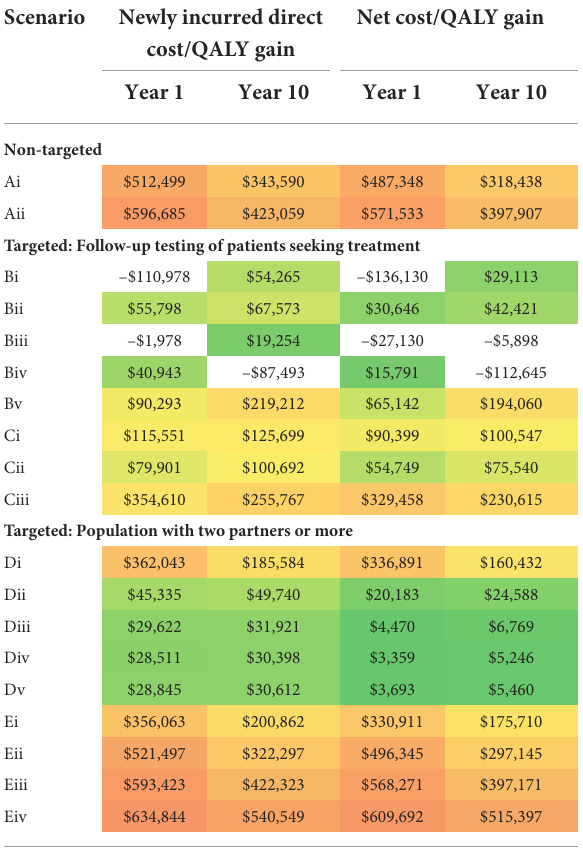
TABLE 5 Results of the cost-effectiveness analysis: costs per QALY gained.